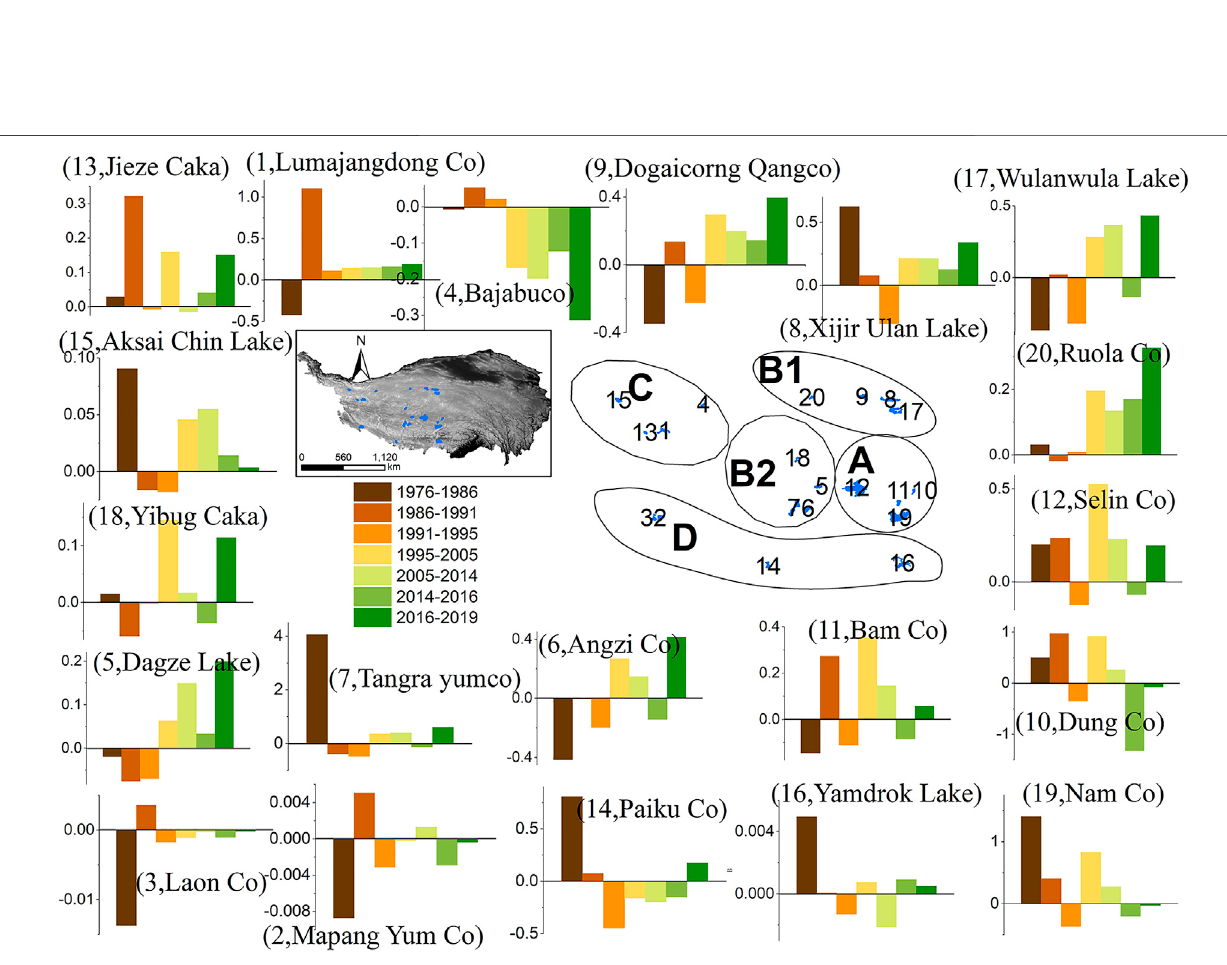
Frontiers in Earth Science |